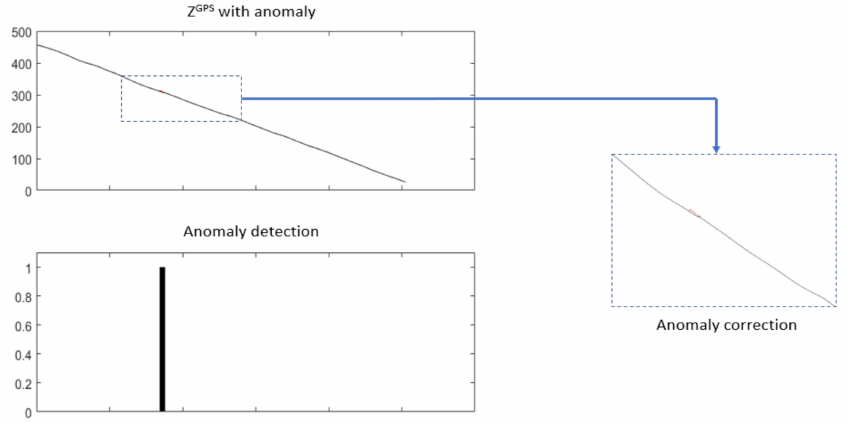
Figure 23. Anomaly detected and corrected using NADCA-L. The small anomaly appears in red.